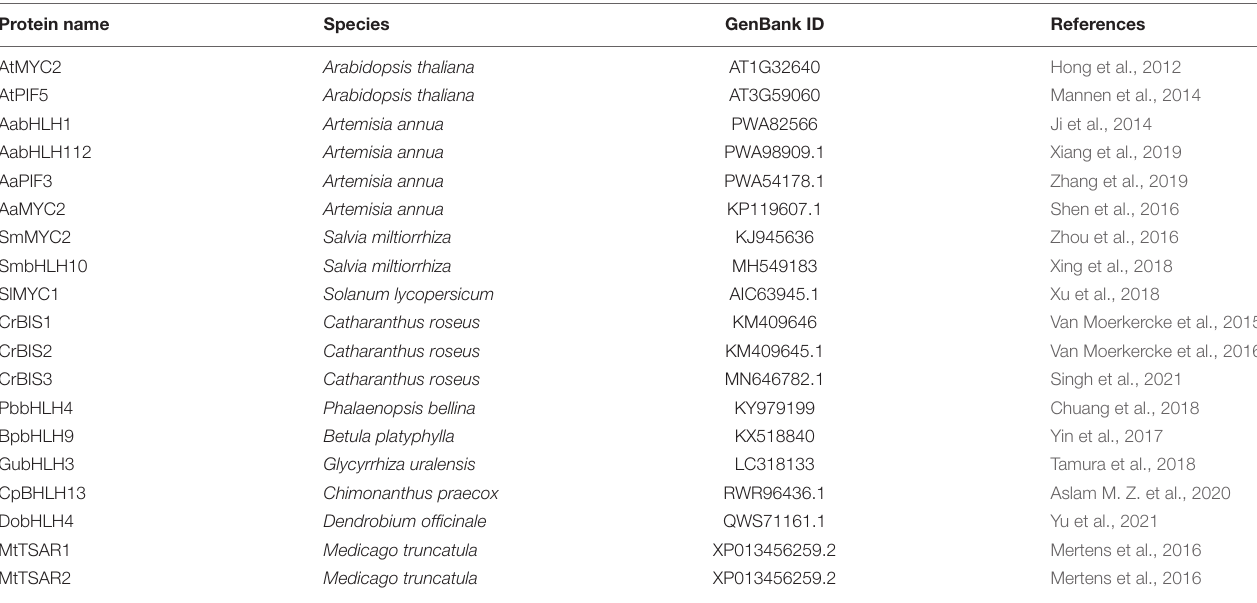
TABLE 2 | Nine known bHLH proteins involved in the regulation of terpenoid biosynthetic